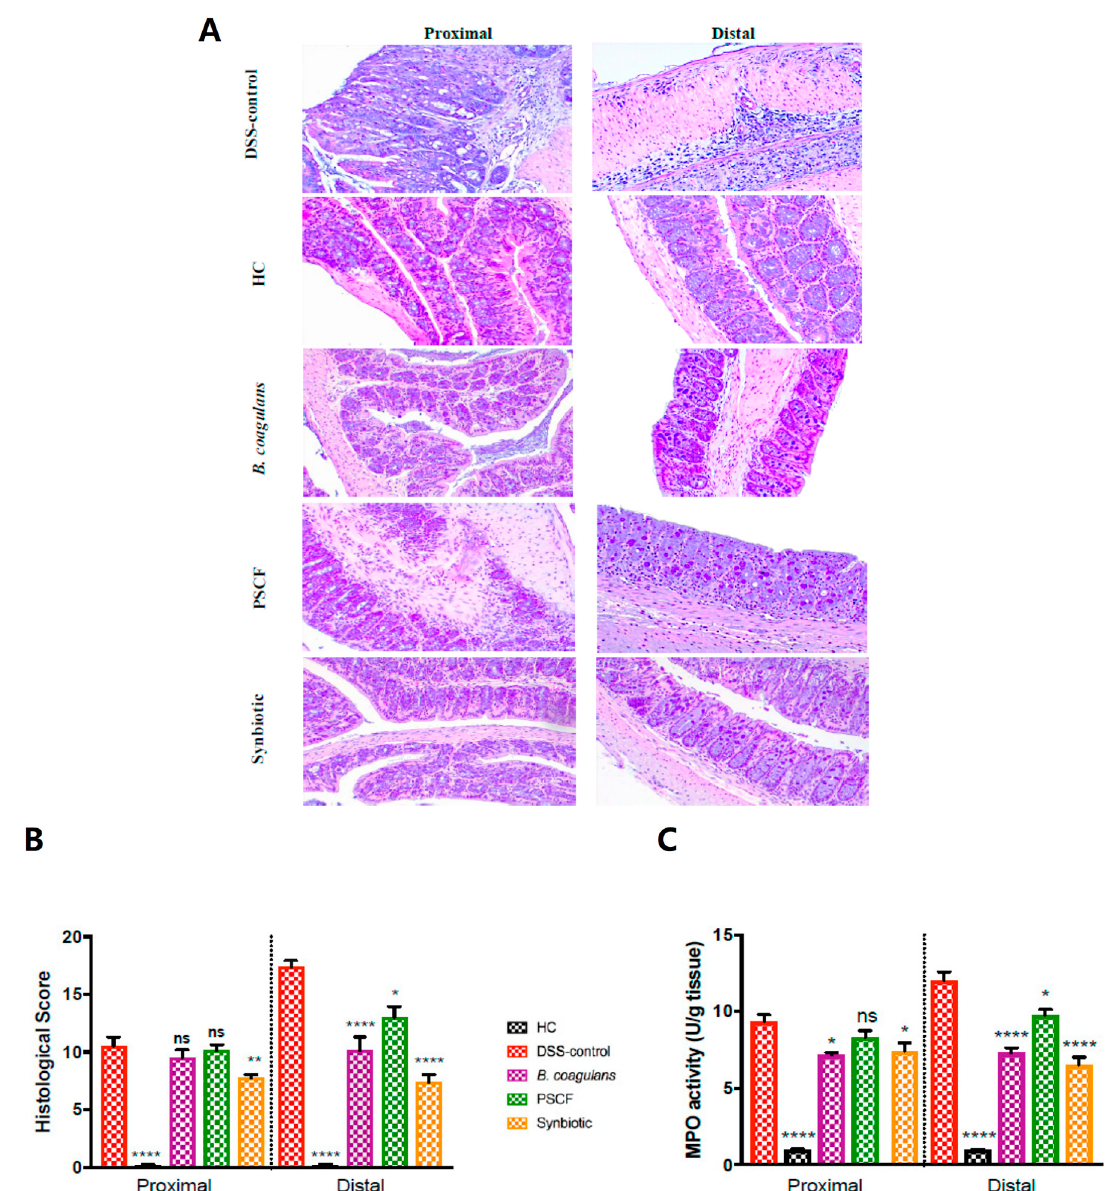
Figure 2. Effect of B. coagulans spores, PSCF and synbiotic treatments on DSS-induced colon injury and inflammation. ( A ) Histological images of proximal and distal colonic tissues stained with hematoxylin and eosin at 20× for each experimental group. ( B ) Histological score calculated after microscopic analyses of proximal and distal sections of the colon. ( C ) Myeloperoxidase (MPO) activity in colonic tissues was determined by colorimetric assay. Results expressed as mean ± SEM ( n = 8 per group), evaluated by one-way ANOVA followed by Tukey’s test (* p < 0.05, ** p < 0.01, **** p < 0.0001).